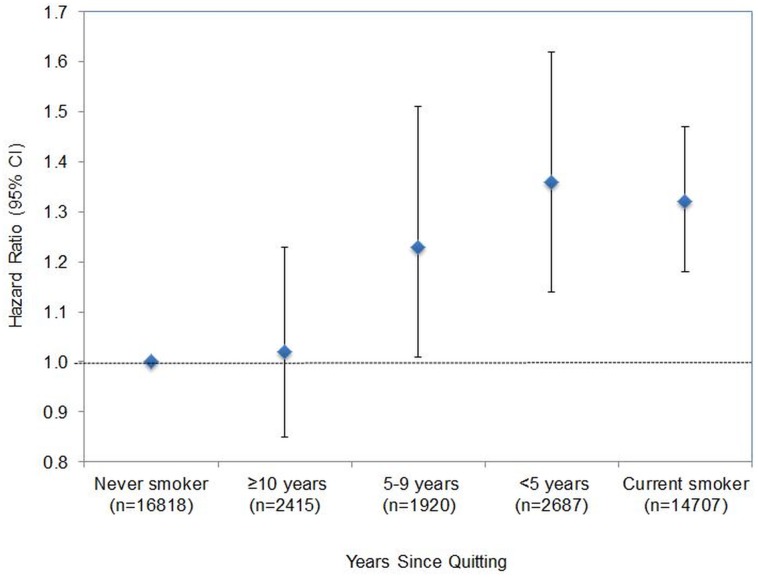
Adjusted hazard ratio for incident diabetes by years since quitting before baseline.Estimates are adjusted for age, sex, worksite, and hypertension. Bars indicate 95% confidence intervals. Never smokers are the reference group.